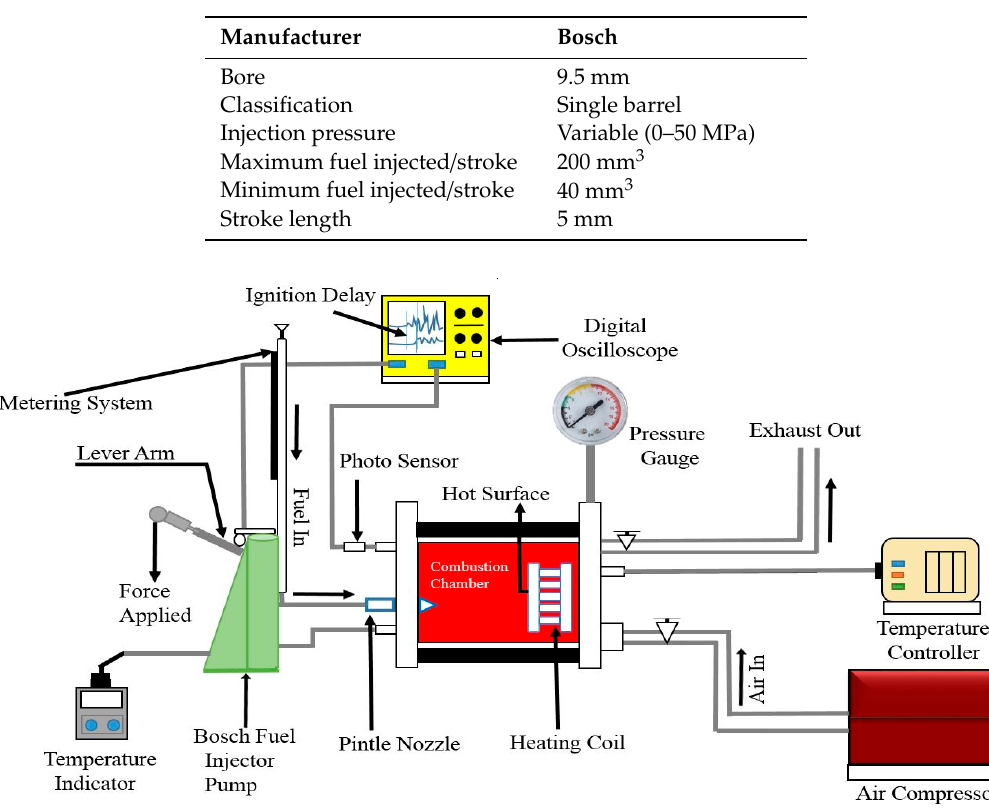
Table 3. Details of fuel pump.